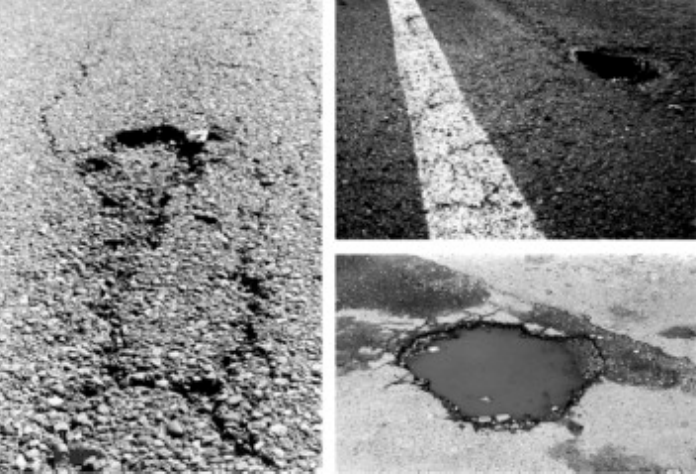
Figure 2. Moisture-induced pavement distresses.